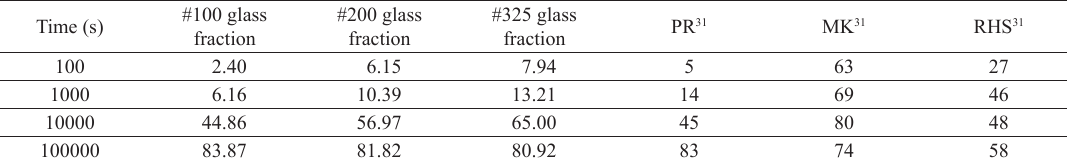
Table 5. Relative loss of electrical conductivity (%) over time (s) for different mineral additions.